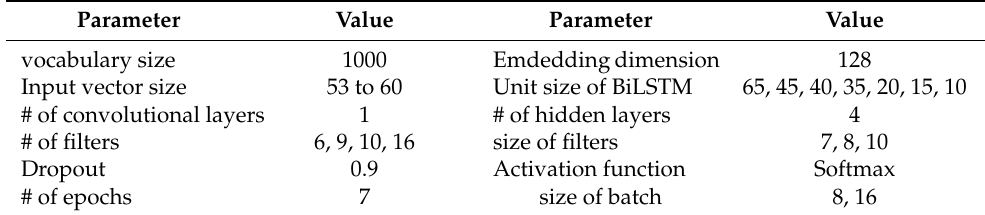
Table 3. CNN-BiLSTM model parameterization.